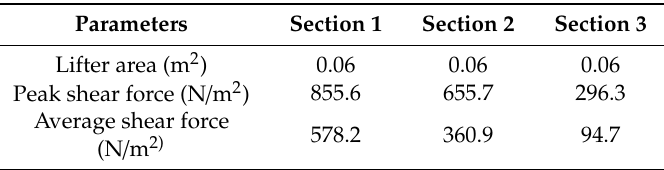
Table 2. Average forces acting on the lifter sections.